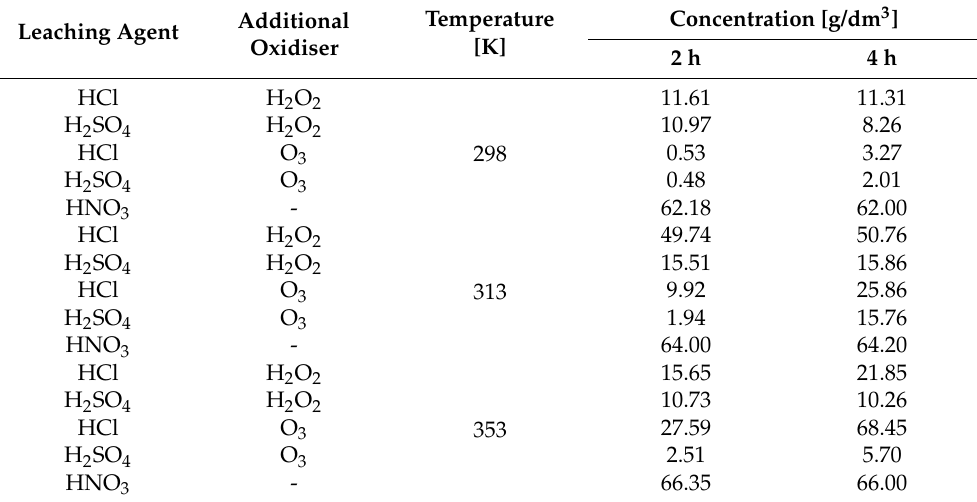
Table 3. Copper concentration obtained after leaching in HNO 3 , HCl, and H 2 SO 4 with the addition of H 2 O 2 or O 3 within 2 h and 4